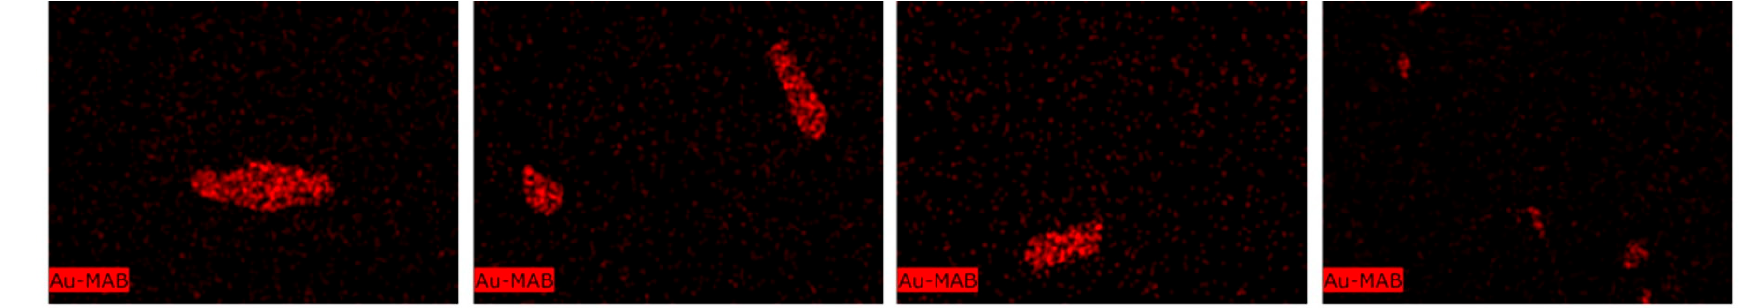
Figure 6. Energy-dispersive X-ray spectroscopy (EDS) element mapping images of gold (Au, high concentrations represented by red spots) grains in pyritic and sideritic Castlecomer coals. Maps are 50 μ m × 50 μ m flat surfaces. Table 1. Selenium (Se), gold, (Au), sulphur (S) and total organic carbon (TOC) content of Castlecomer coal samples. Locality information also shown, as well as a qualitative indication of presence of gold in each sample (based on SEM–EDS observations). Sample Code Sample